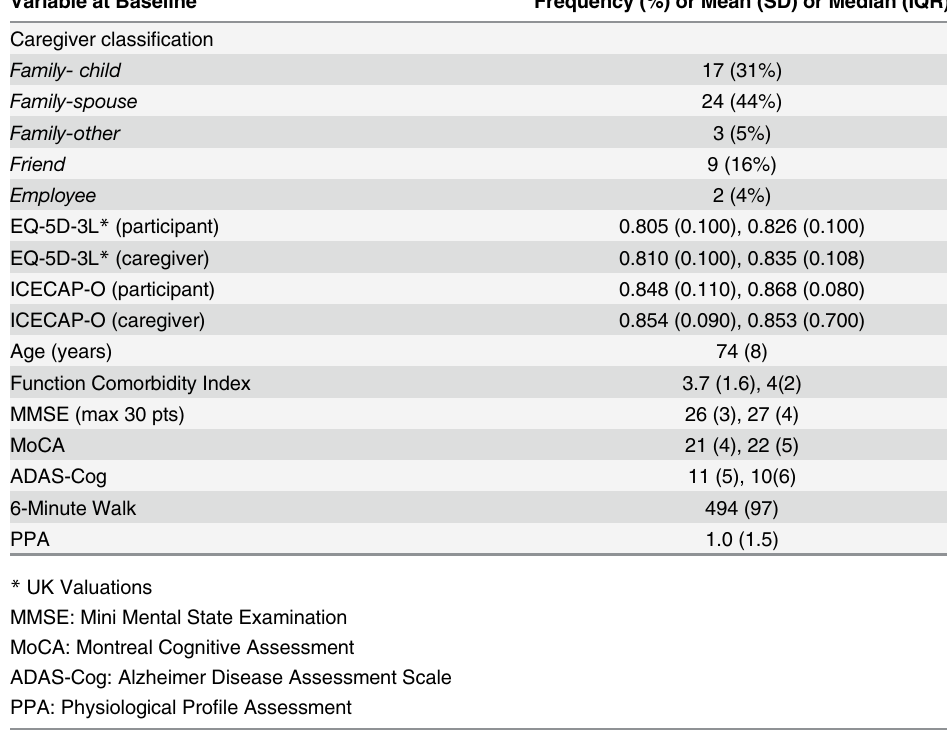
Table 1. Characteristics of the VCI participants at